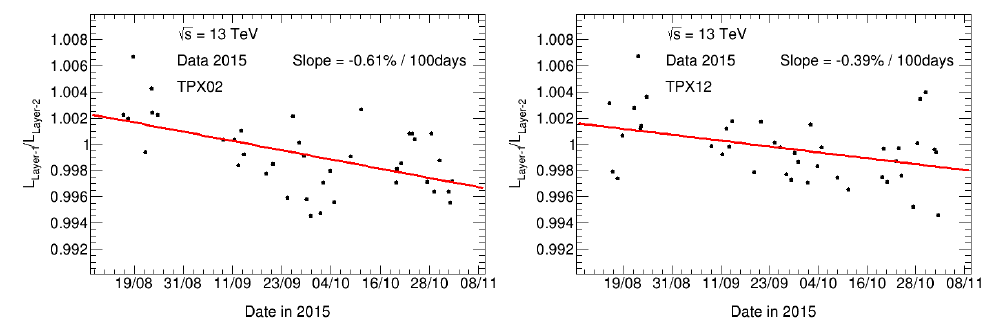
Figure 44. Time history of the luminosity ratio measured by layers 1 and 2 for TPX02 and TPX12. The 2015 TPX data are divided into luminosity blocks of typically one minute length and then grouped into LHC fill time periods. The size of the statistical error bar is below the size of the data point. A linear fit is applied to determine the slope. LHC fills from August to November 2015. Taken from Ref.